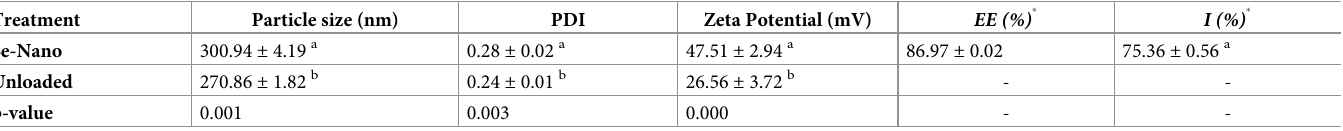
Table 1. Particle size, polydispersity index (PDI), zeta potential, entrapment efficiency ( EE ), and radical scavenging activity ratio (I) of chitosan nanoparticles loaded with selenium (Se-Nano) and unloaded (control without